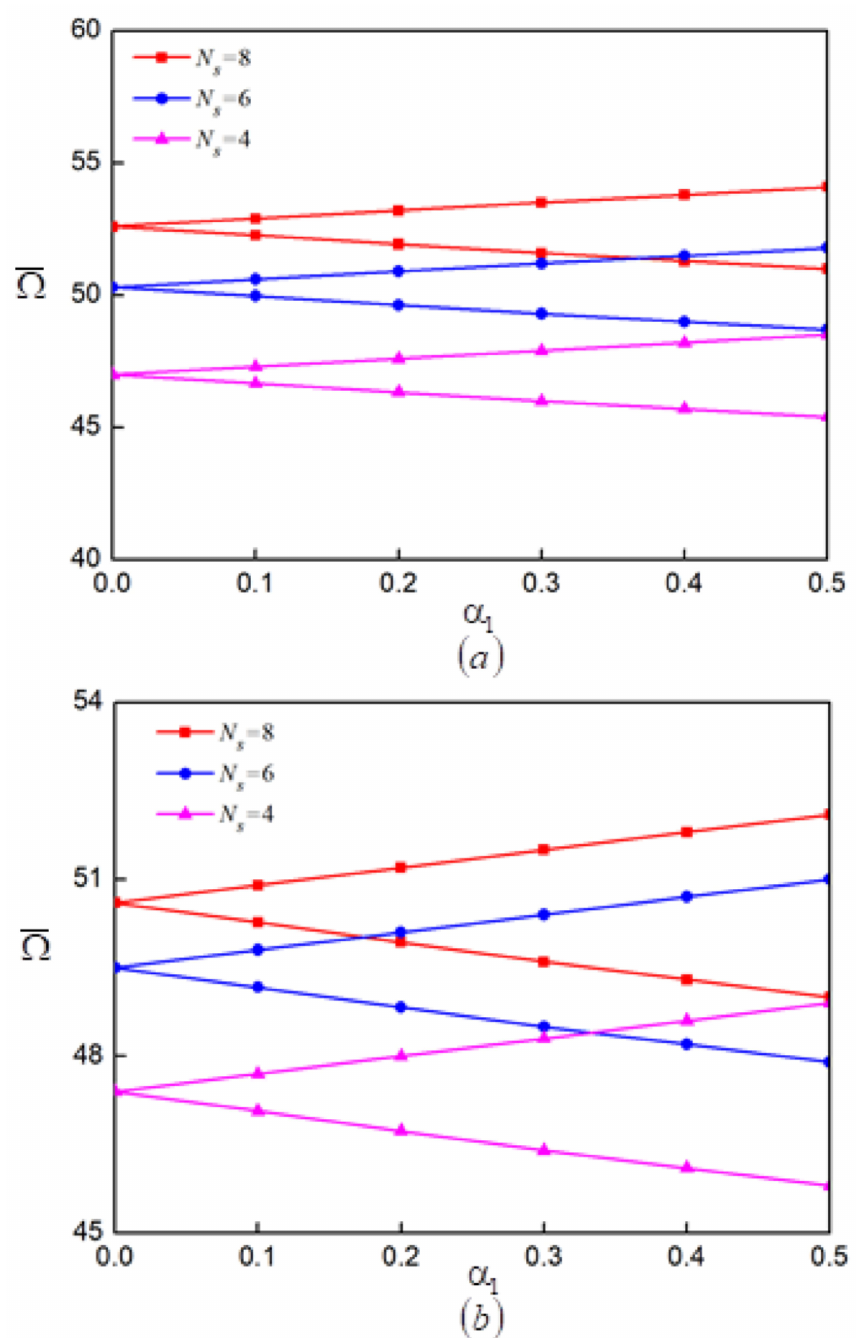
Figure 17. The dynamic unstable regions of the CFRP laminated cylindrical shell with different N s : ( a ) the first mode, and ( b ) the second